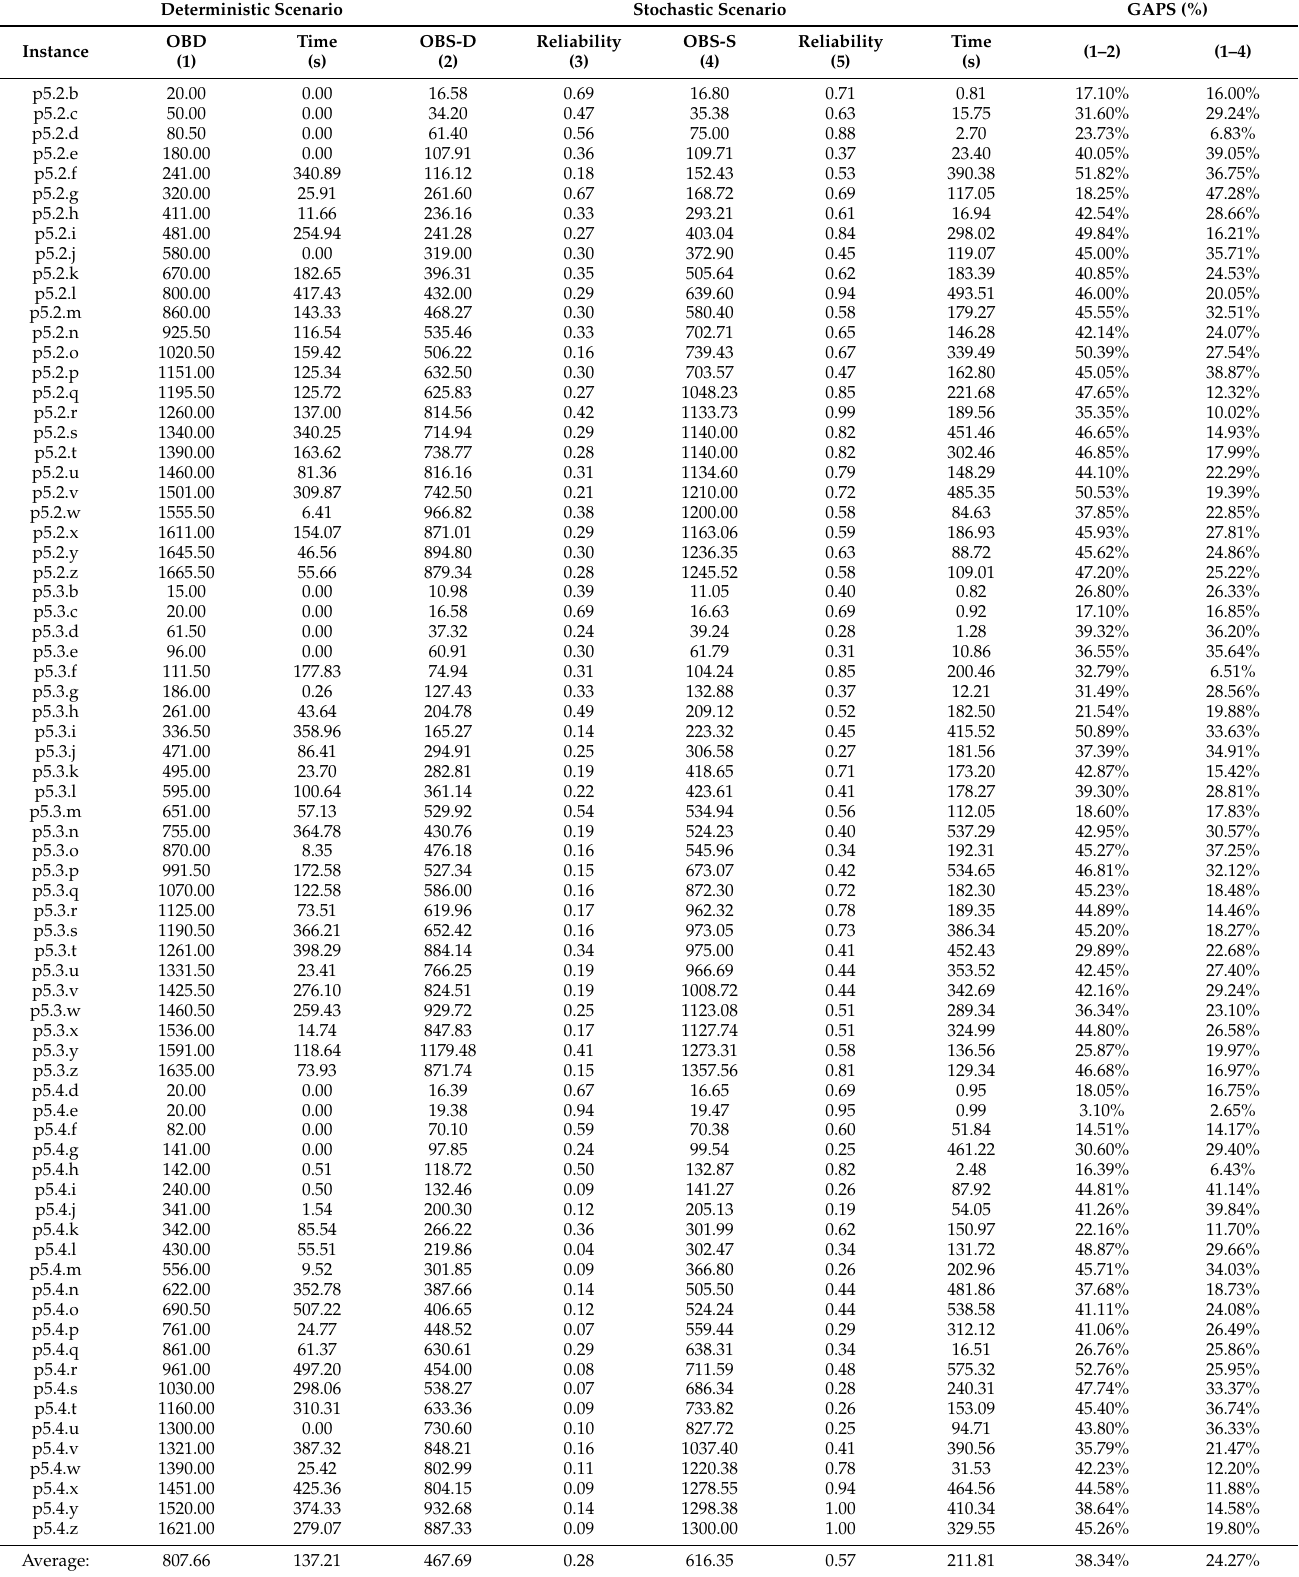
Table 10. Results for p 5 instances in a stochastic scenario with a high variance ( c =